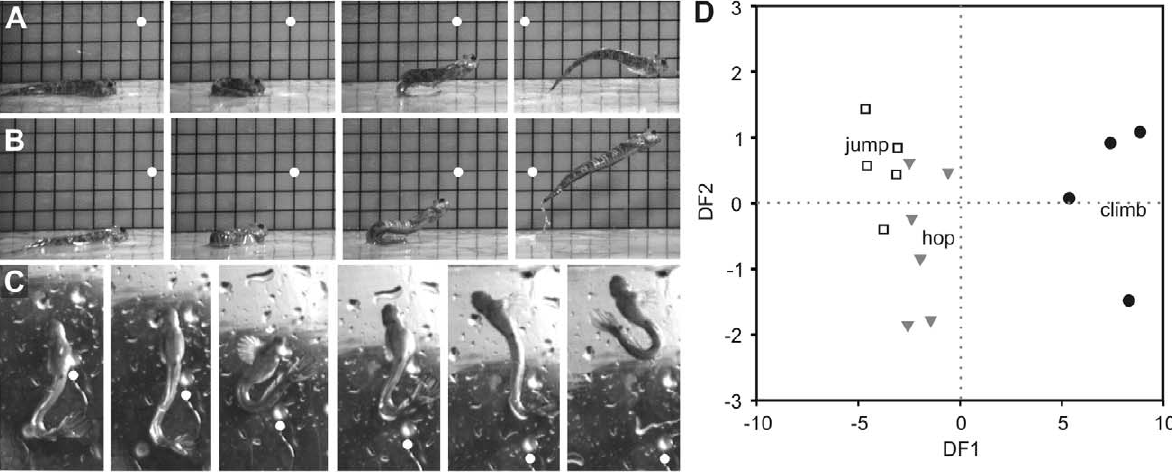
Figure 4. Three terrestrial locomotor modes performed by Alticusarnoldorum . a , Hopping, b , jumping, and c , climbing. d , Results of a discriminatory analysis on four principal components derived from two principal components analysis (PCA) models of preparatory and propulsive kinematics. All three locomotor modes are distinct (Wilks’ Lambda: P , 0.0001; ANOVA: F=159.37, P , 0.0001) and categorized with 93.7% accuracy (14 of 15 correct). See Tables 1 and S1 for a list of variables included in the PCA models.